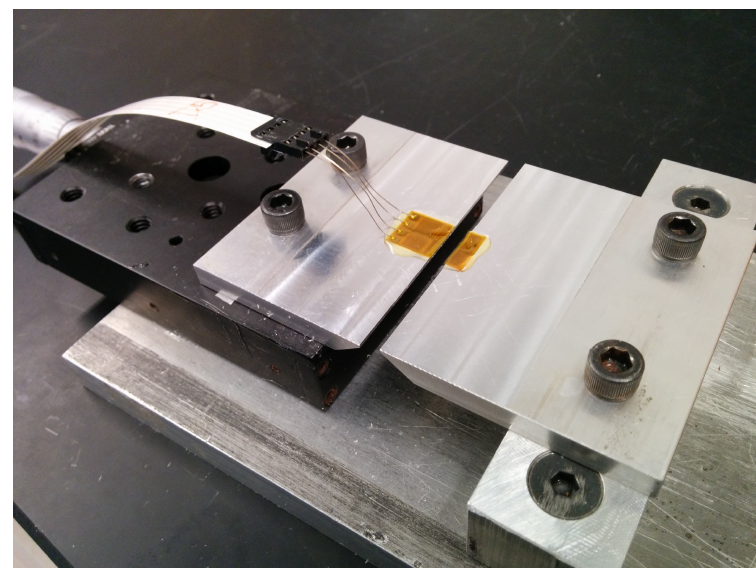
Figure 9. Crack test setup.